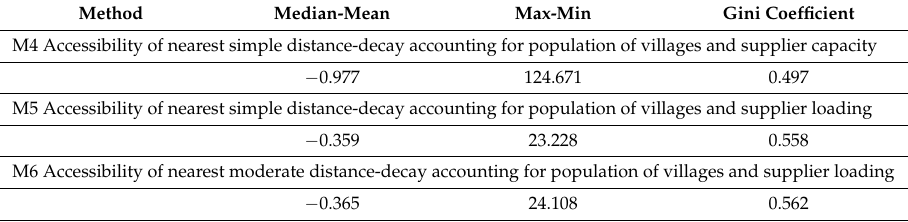
Table 8. Measures of spatial inequality of community care resources using methods M4–M6 (estimated by